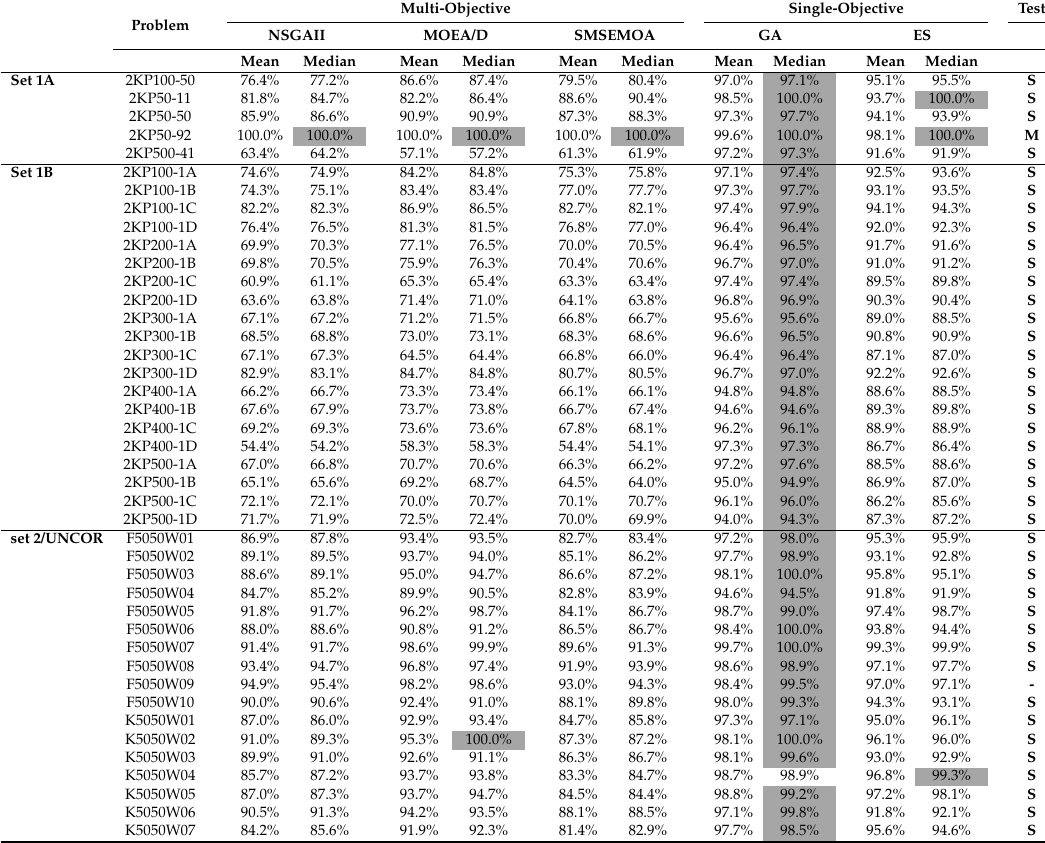
Table 6. Results for KNP instances (objective